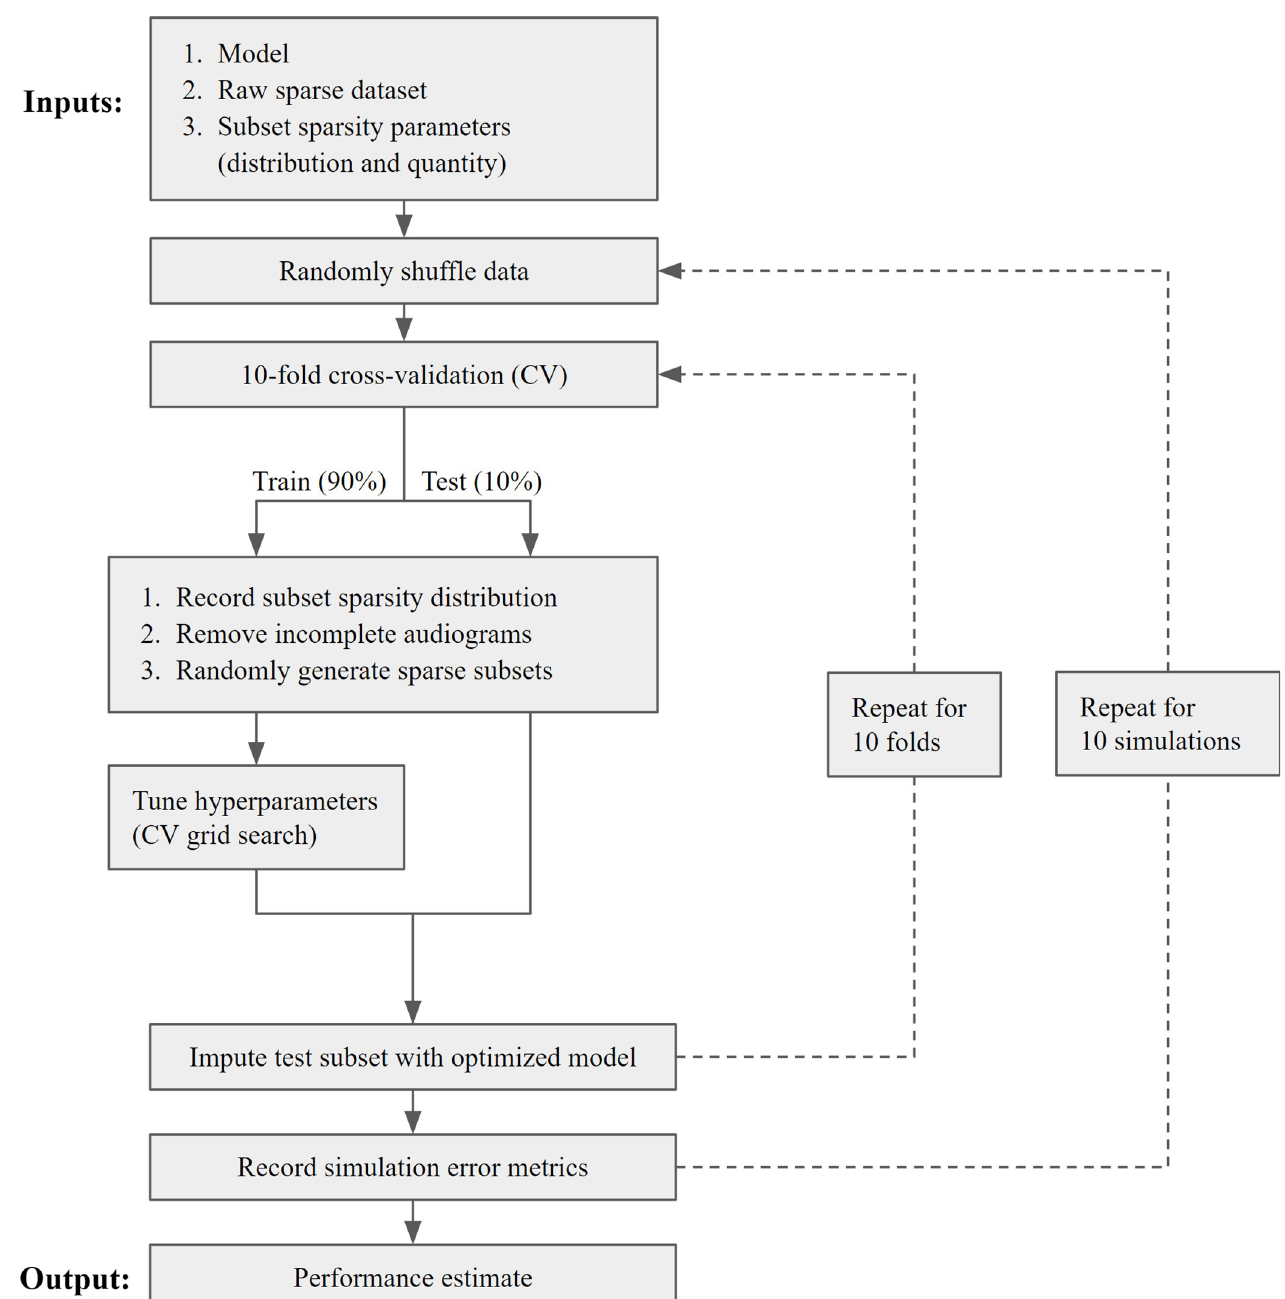
Fig 2. Performance assessment pipeline. Diagram of steps for assessment of model performance with repeated simulations of nested cross-validation. Output consists of model performance mean and confidence intervals averaged across all 10 simulations. https://doi.org/10.1371/journal.pone.0281337.g002 For each fold, the parent dataset (n = 7,451) was divided into training (90%) and test (10%) subsets, with test subsets sampled without replacement across folds. Sparsity distribution was calculated independently for each subset; incomplete instances were subsequently removed to create dense subsets. This was done following the split into train and test subsets to avoid